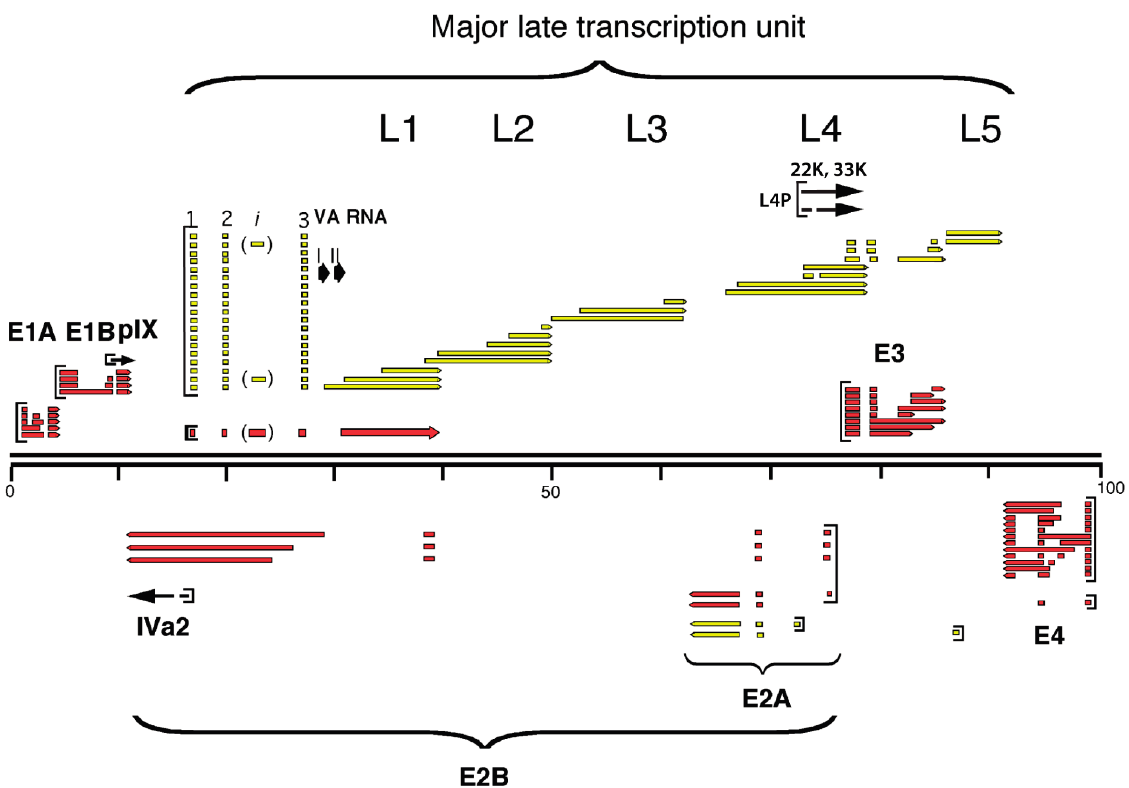
Figure 1. Schematic representation of the Ad5 genome and the expressed viral transcripts. The early transcripts are shown in red and the late ones are marked in yellow. Intermediate genes are indicated as black